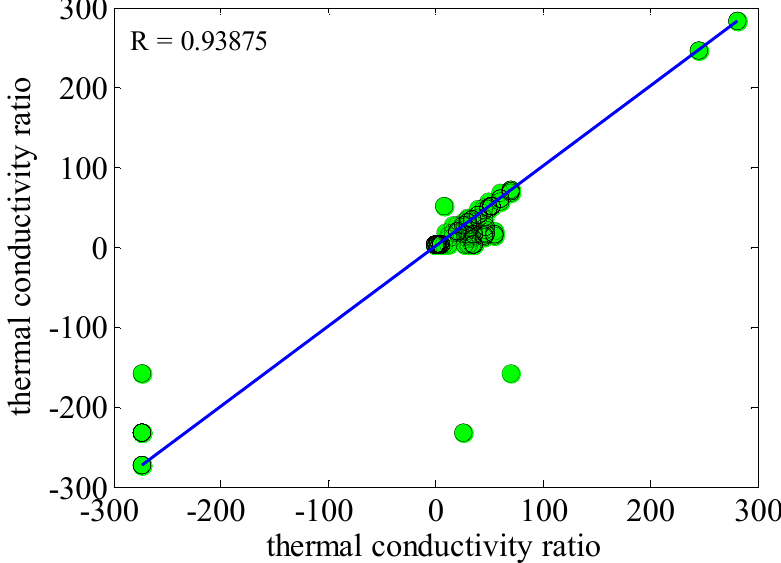
Figure 10. Correlation coefficient data based on investigating the predicted and experimental thermal conductivity ratio.